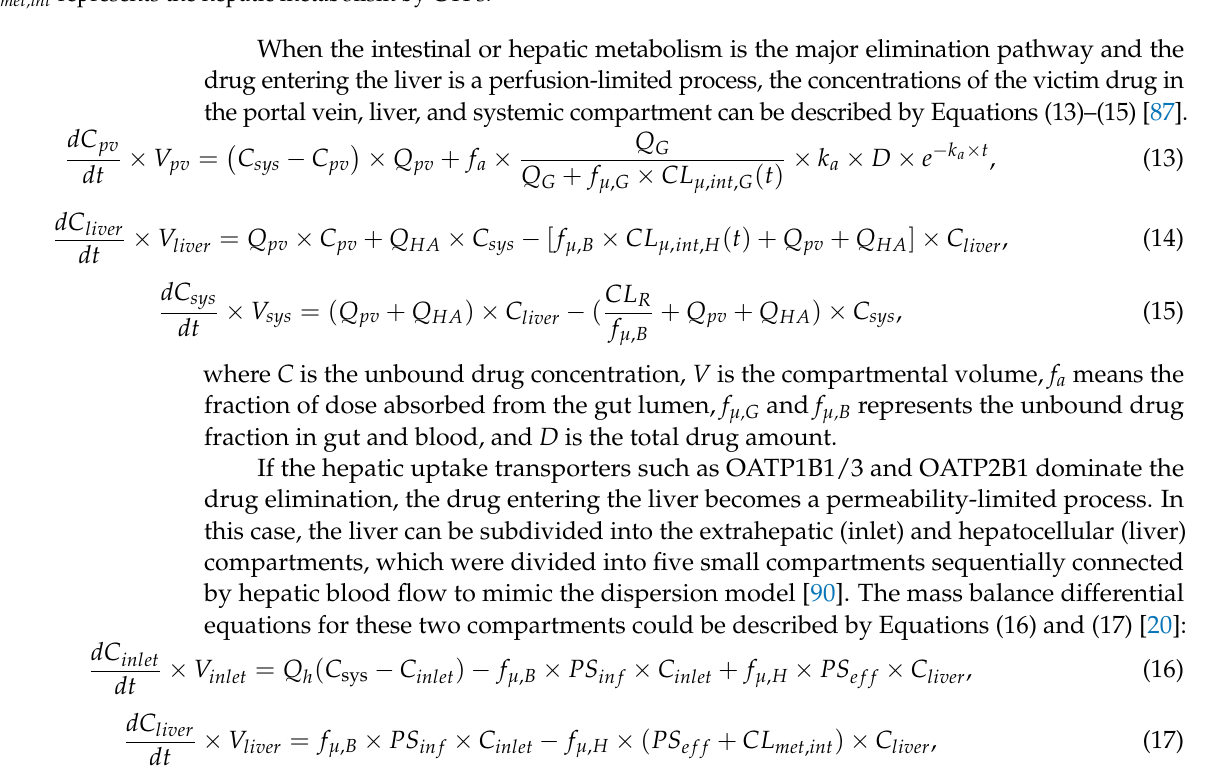
Figure 4. Sketch for major compartmental modules and related parameters. The subscripts of pv, G , H , HA and sys represent the portal vein, gut, liver, hepatic artery and systemic compartment, respectively. Q is the blood flow rate, K a is the absorption rate constant, F G is gut availability after intestinal metabolism; CL µ ,int,H and CL µ ,int,H are the unbound intrinsic clearance in liver and enterocytes. PS inf is the overall influx intrinsic clearance, PS eff is the overall efflux intrinsic clearance, and CL met,int represents the hepatic metabolism by